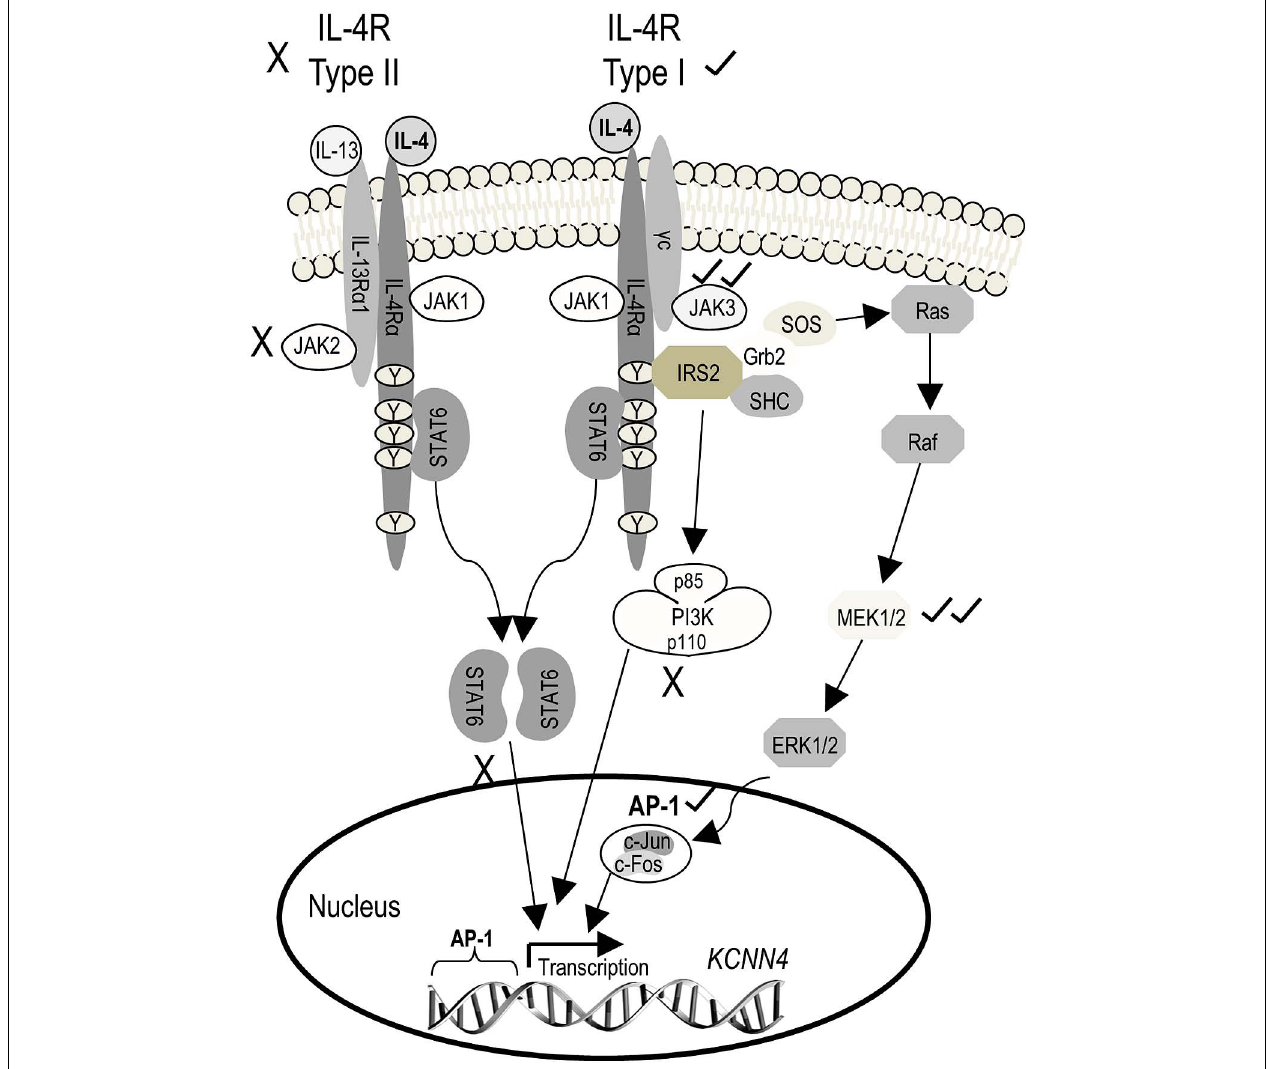
FIGURE 4 | Schematic diagram depicting known IL-4 signaling pathways and the outcomes observed. The initial step is IL-4 binding to the IL-4 receptor α subunit (IL-4R α ), which can then heterodimerize with either the common gamma chain ( γ C) to form the type I receptor or with IL-13R α 1 (which binds IL-13) to form the type II receptor. Heterodimerization of either receptor subtype activates JAKs but the specific JAK depends on the receptor subunit composition. JAK1 associates with IL-4R α , and is thus common to both receptor subtypes. JAK3 associates with γ C of the type I receptor, and JAK2 associates with IL-13R α 1 of the type II receptor. For both receptor subtypes, activated JAKs phosphorylate tyrosine residues on IL-4R α , which then act as docking sites for signaling molecules (i.e., STAT6, IRS2) that are then phosphorylated. Phosphorylated STAT6 dimerizes and translocates to